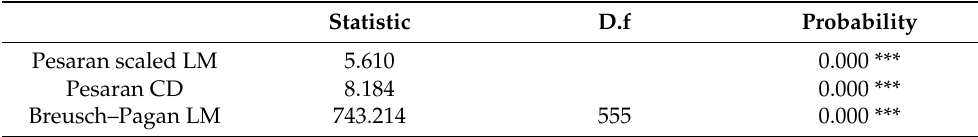
Table 3. RCD Test.